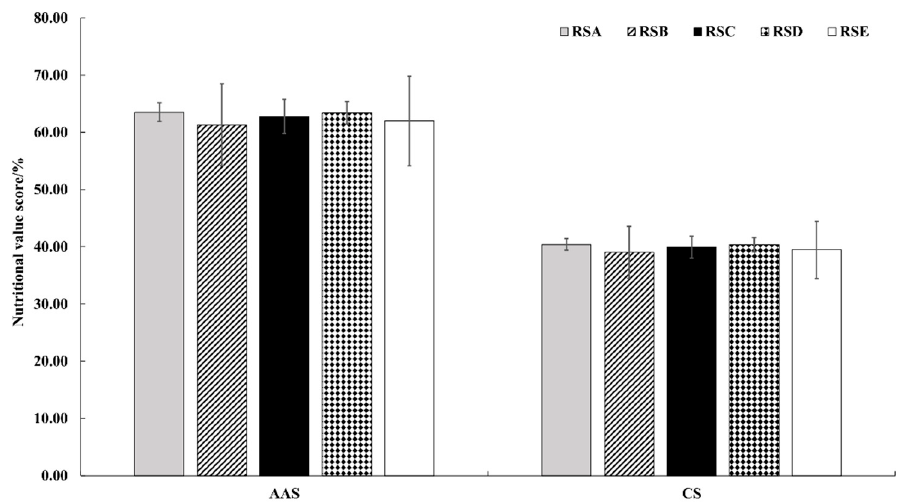
Figure 7. Effect of different rotation systems on amino acid scores and chemical scores of M. importuna . AAS, amino acid scores; CS, chemical scores.